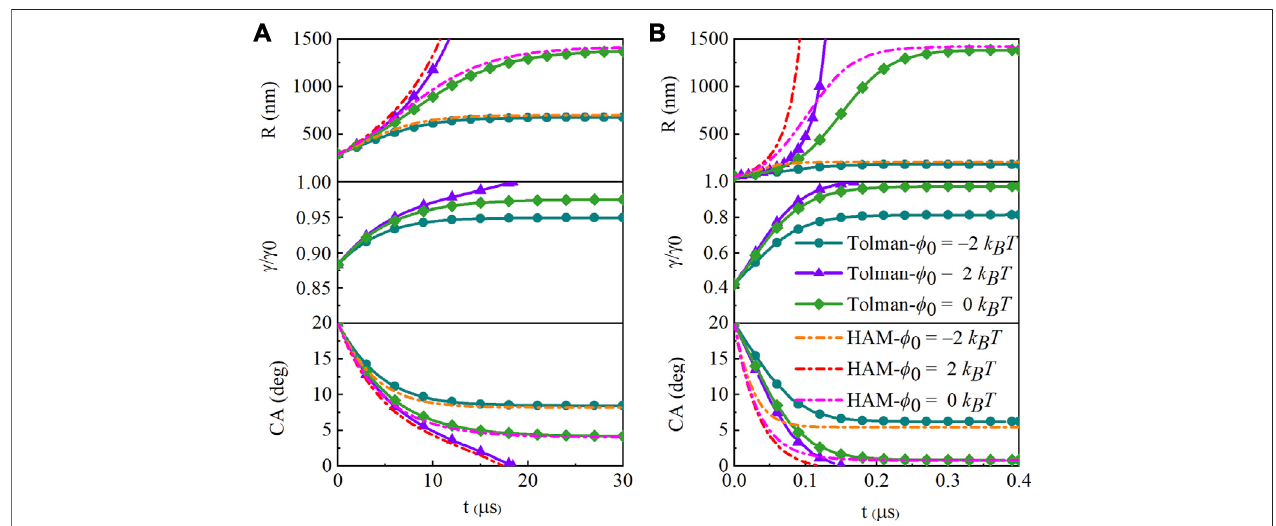
FIGURE2| Evolutionofthecurvatureradius,Tolman-dependencesurfacetensionandcontactangle(CA)withtheinitialcontactangle θ 0 (cid:1) 20 o andfootprintradius (A) L (cid:1) 100 nm, (B) L (cid:1) 20 nm. The far- fi eld concentration is c ∞ (cid:1) 2 c s . The curves are for hydrophobic ( ϕ 0 (cid:1) − 2 k B T , circle symbol), hydrophilic ( ϕ 0 (cid:1) 2 k B T , triangle symbol), and neutral ( ϕ 0 (cid:1) 0 k B T , rhombus symbol) surfaces. The dashed ones are for hydrophobic attraction model (HAM) with the same surface.